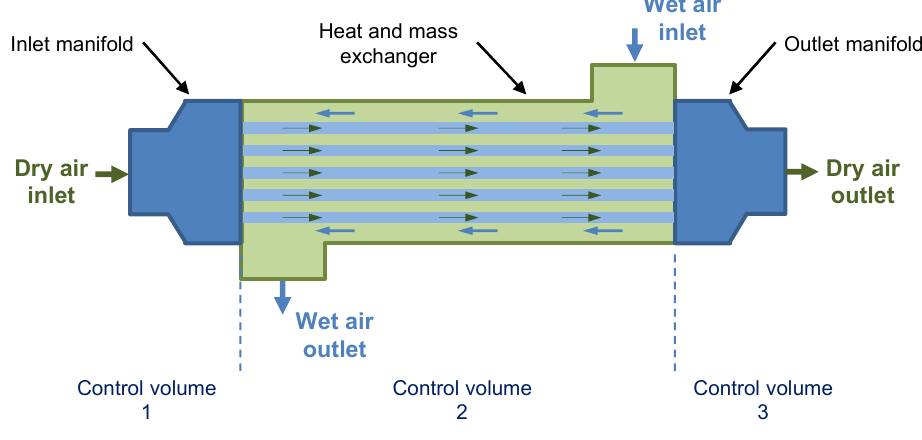
Figure 1. Schematic diagram of the humidifier module.